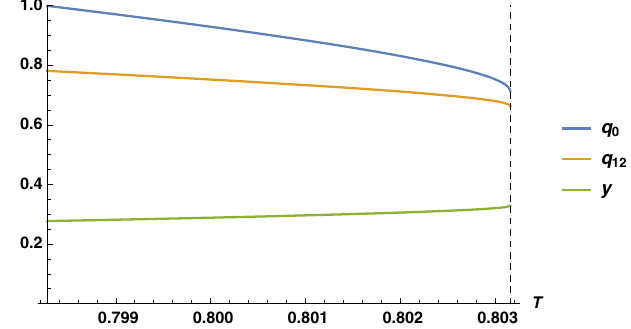
FIG. 10. Aging solution with memory of the initial configu- ration as predicted by the derivative of the FP potential for the ( 3 þ 4 )-spin model: q 0 (upper line), q 12 (central line), and y (lower line) as a function of T . The temperature in the plot is in 0 . 7982754 and T 0 . 8031557 the range between T 0 ¼ SF ¼ (marked by a dashed vertical line). Notice that in this solution, we have y ≈ 0 . 3 , which is quite far from the value y ≈ 0 . 52 that we observe in the numerical solution to the dynamical equations. Also notice that q 12 and q 0 have finite values when the solution appears at T 0